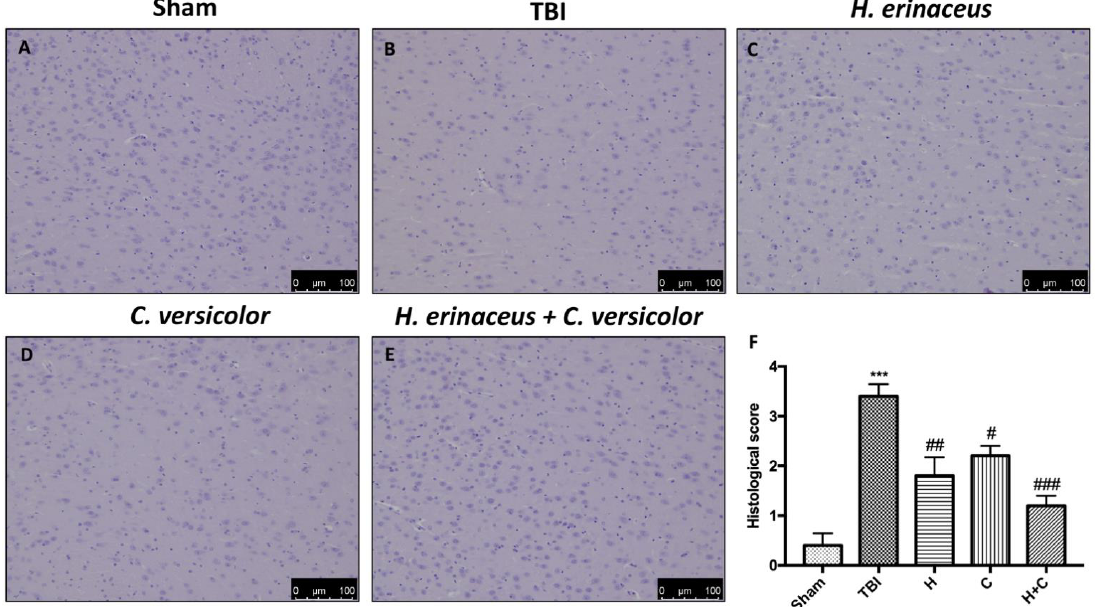
Figure 2. Effect of H. erinaceus (H), C. versicolor (C) and H. erinaceus + C. versicolor (H + C) on histological parameters in the midbrain after chronic head injury. The Sham group showed no evidence of cell degeneration in the substantia nigra (SN) ( A ), while neuronal cell loss was observed in the animals of the TBI group ( B ). Treatment with H ( C ), C ( D ) and especially H + C ( E ) restored the architecture of the midbrain. The data are representative of at least three independent experiments and are expressed as the mean ± SEM of n = 5 male CD1 mice for each group. ( F ) *** p < 0.001 with respect to Sham; ## p < 0.01 vs. TBI; # p < 0.05 with respect to TBI; ### p < 0.001 compared to TBI.